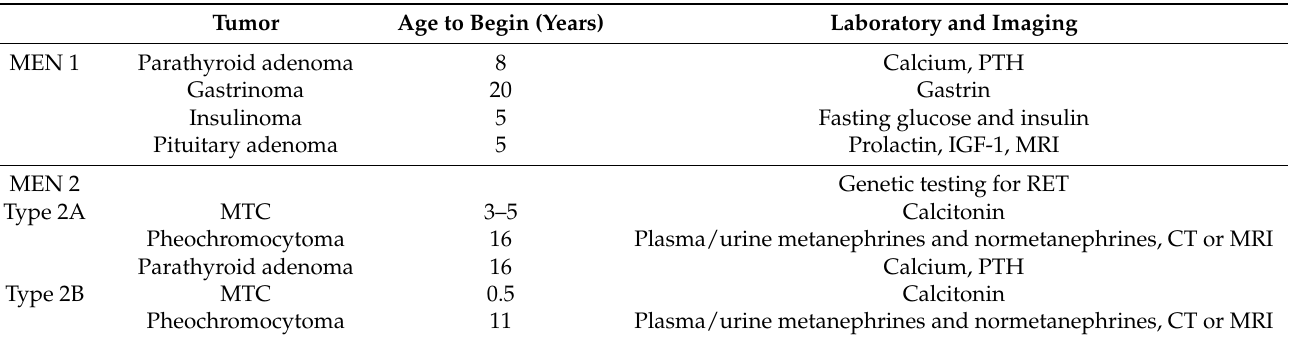
Table 2. Screening recommendations for MEN1 and